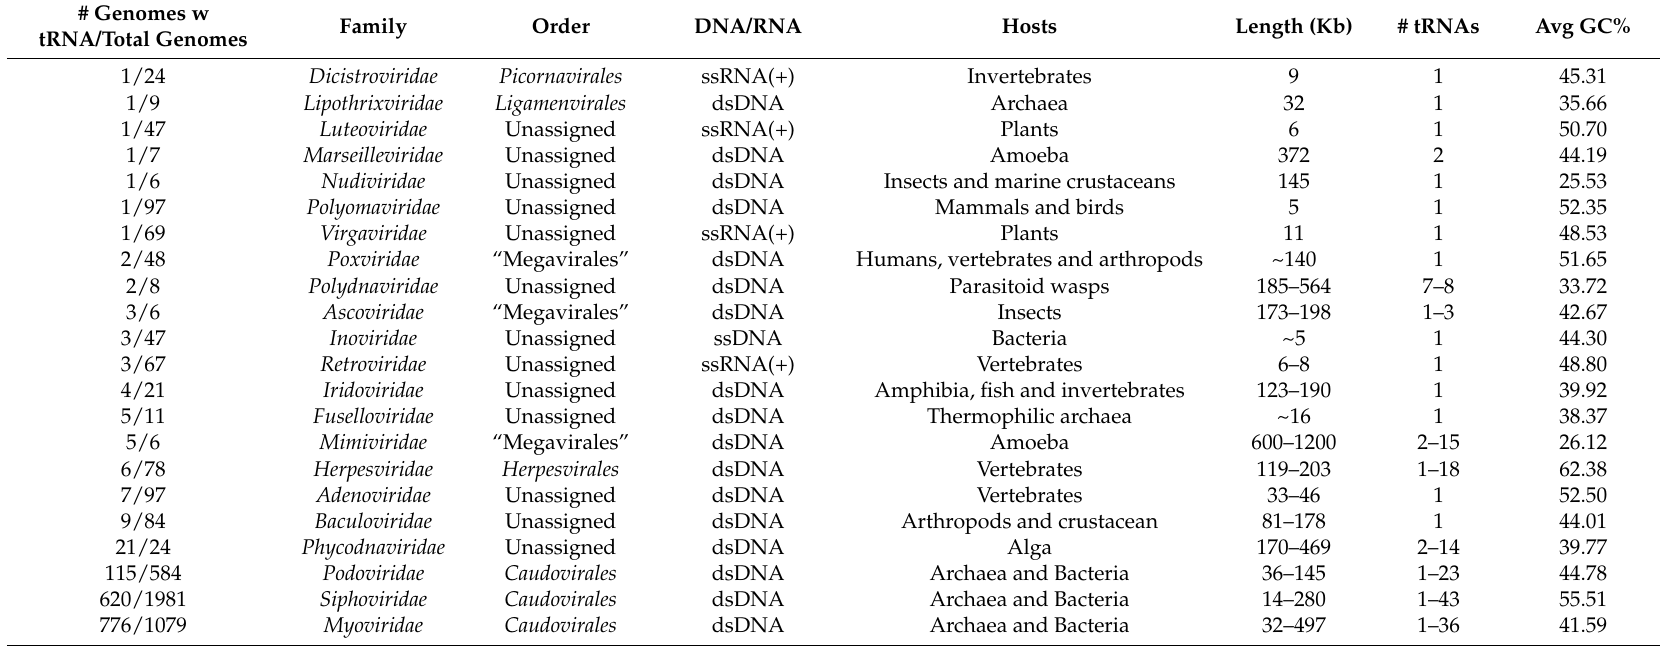
Table 1. Number and features of viral families harboring tRNA